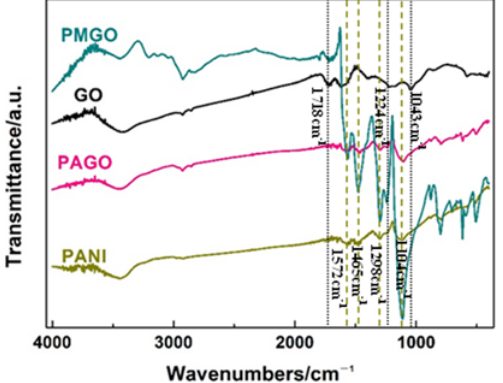
Figure 2. Infrared spectrum of synthetic powder .